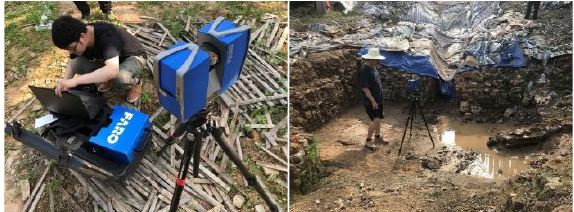
Figure 10. Data collection work on